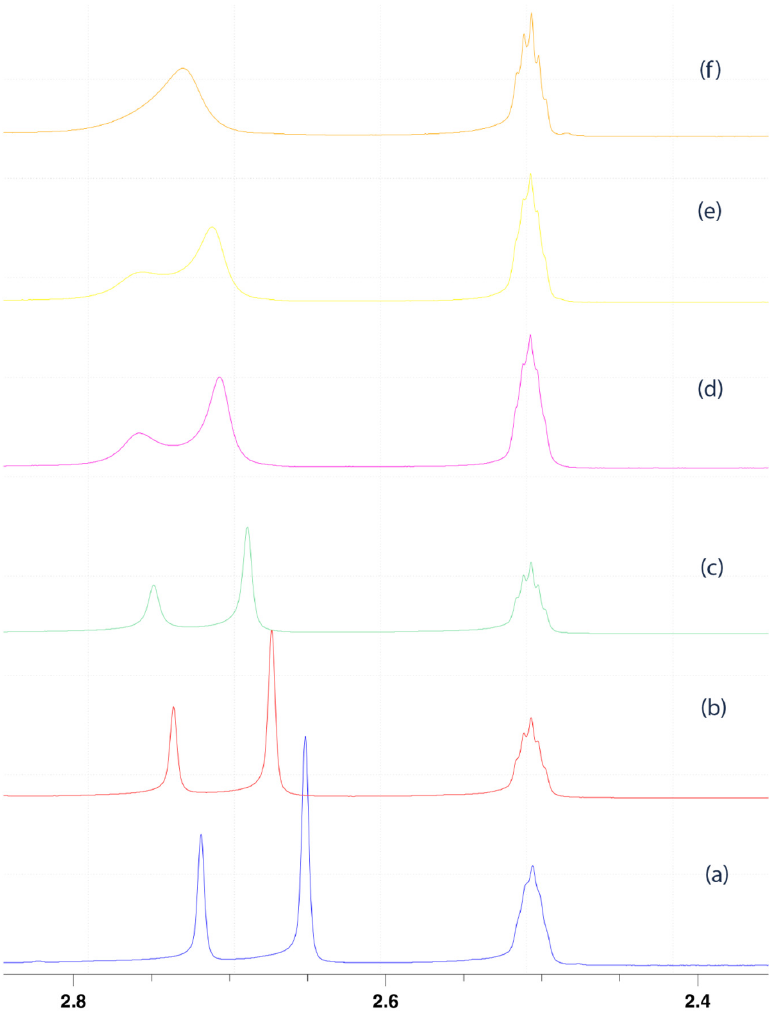
Figure 1. The 1 H NMR spectrum (400 MHz) of BHFA-NMe in DMSO-d 6 at 20 °C.